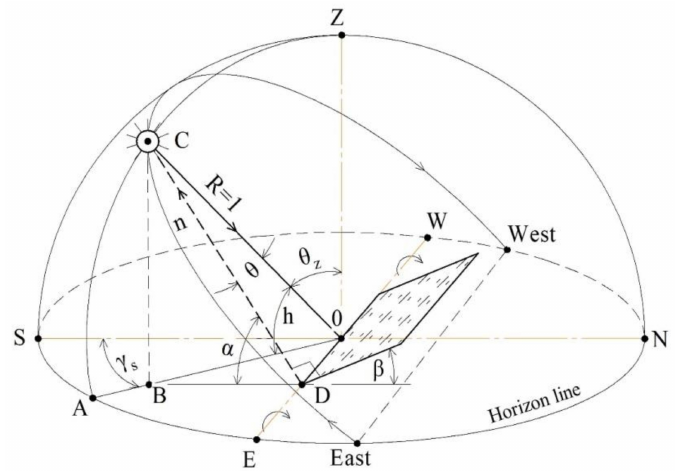
Figure 7. Scheme for measuring the parameters of irradiation of the surface while it rotates around the horizontal axis “east-west” ( HEW axis tracker)—designed based on